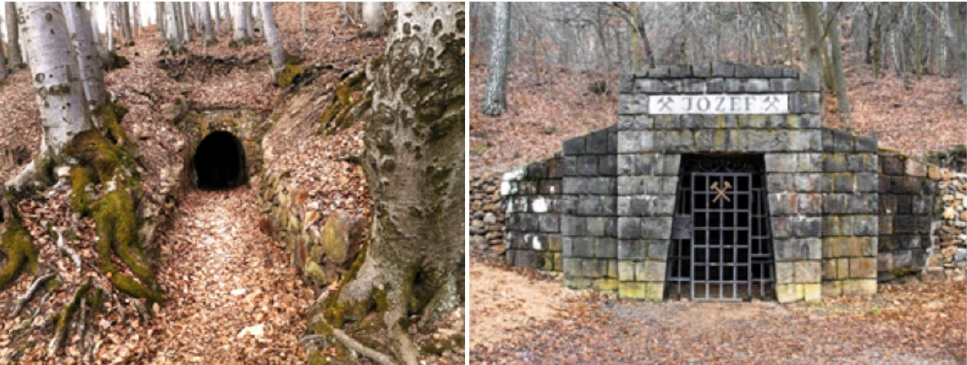
Figure 7. Remnants of mining works in the Libanka mining district, on the right side is an entrance to the visiting mine: Jozef adit (photo by Silvia Plagutová).